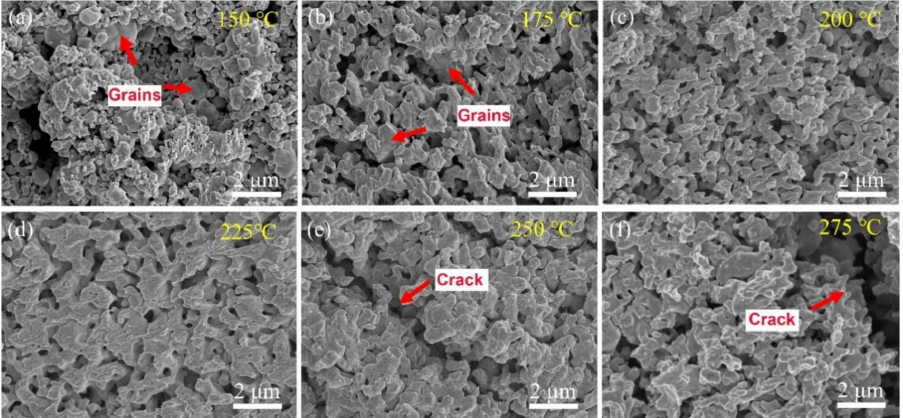
Figure 7. The SEM images of the fracture surface of specimens sintered at the following different temperatures: ( a ) 150 ◦ C, ( b ) 175 ◦ C, ( c ) 200 ◦ C, ( d ) 225 ◦ C, ( e ) 250 ◦ C and ( f ) 275 ◦